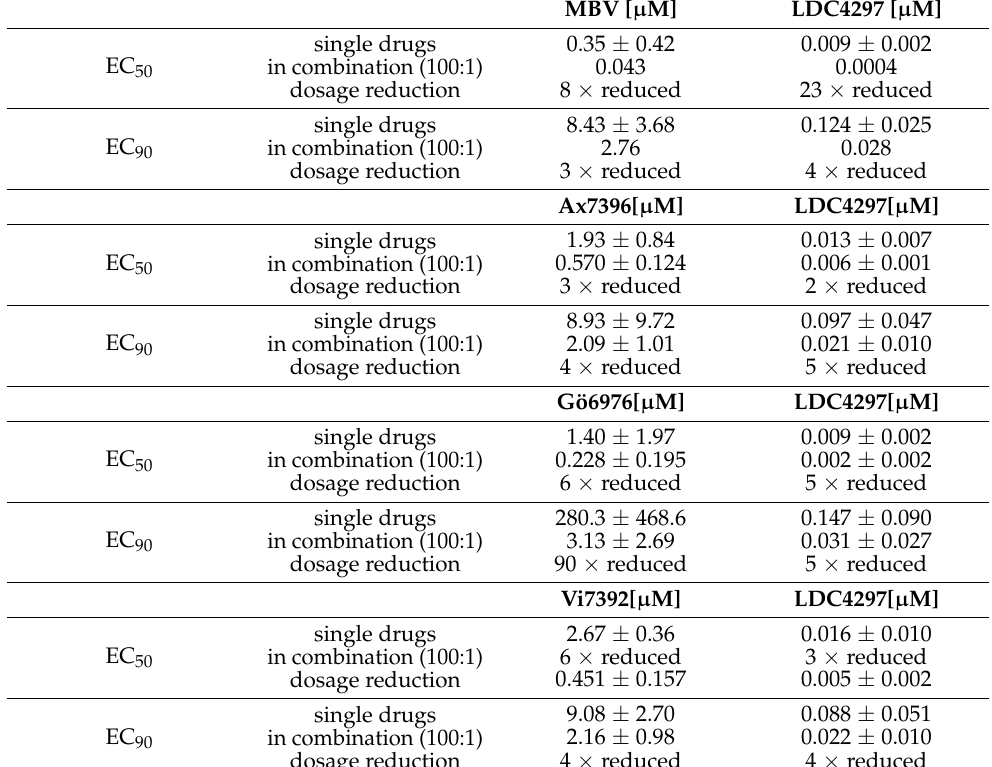
Table 7. Overview of EC 50 and EC 90 values of various pUL97 inhibitors (left), CDK7 inhibitor LDC4297 (right), in both cases determined for the single drugs (upper) and in combination (lower). Analysis was based on the antiviral activity measured against HCMV AD169-GFP. The x-fold dosage reduction expresses the benefit of drug combination over single-drug treatment. Each EC 50 and EC 90 value represents at least three independent experimental replicates based on measurements in biological